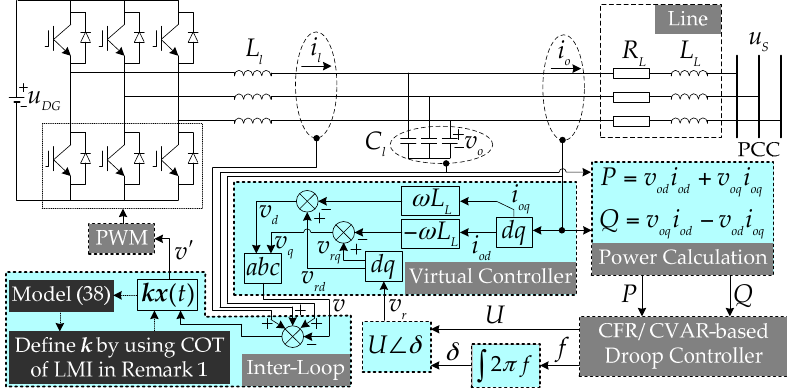
Figure 5. Improved control system of DG in low-voltage microgrid.